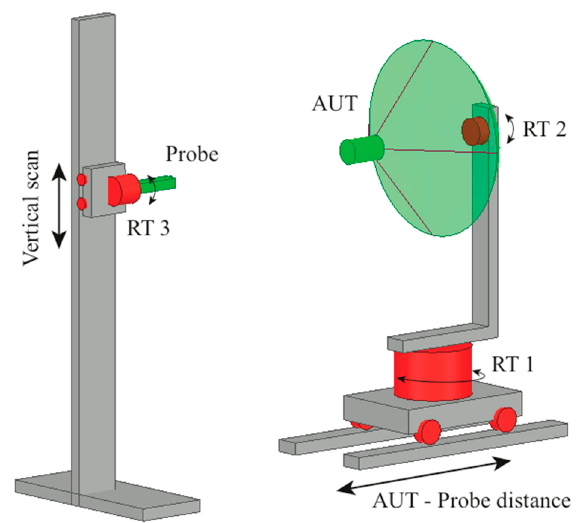
Figure 6. Sketch of the versatile UNIversity of Salerno (UNISA) near-field (NF) facility. The AUT is an E-plane monopulse antenna operating at 10 GHz in the sum mode. It has The amplitude and phase of the voltages p V and r V on the meridians at 0 are compared in Figures 7 and 8, with those measured at high resolution (0.25°-step) on the same meridians and assumed as references. The comparisons relevant to the amplitudes of p V and r V on the meridian at